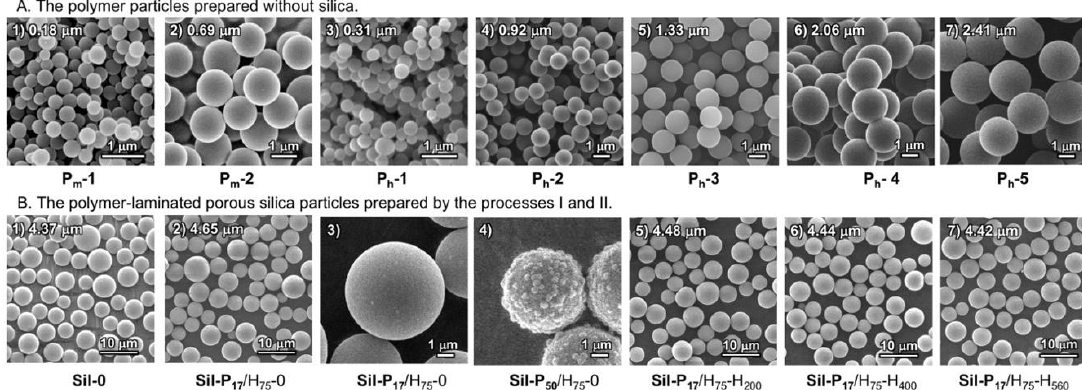
Figure 2. Scanning electron micrographs of the particles ( A ) without and ( B ) with silica, which were obtained by polymerization from DHN and TMTA. The size ( µ m) indicated in each photo corresponds to the average diameters of the particles. ( A ) The preparation condition is summarized in Table S1. The photos A - 1 and A - 2 show the particles prepared with microwave heating at 150 ◦ C. The photos A - 3 , A - 4 , A - 5 , A - 6, and A - 7 show the particles prepared without microwaves at 75 ◦ C. ( B ) The preparation condition is summarized in Table 1. The photo B-1 is for the raw silica ( Sil-0 ) before polymerization. The photos B - 2 , B - 3, and B - 4 show the particles after polymerization with Sil-0 . The photos B - 2 and B - 3 are for the comparison of the surface smoothness between Sil-P 17 and Sil-P 50 , respectively. The photos B - 5 , B - 6, and B - 7 show the Sil-P 17 / H 75 -0 particles after heat treatment at 200 ◦ C, 400 ◦ C, and 560 ◦ C,